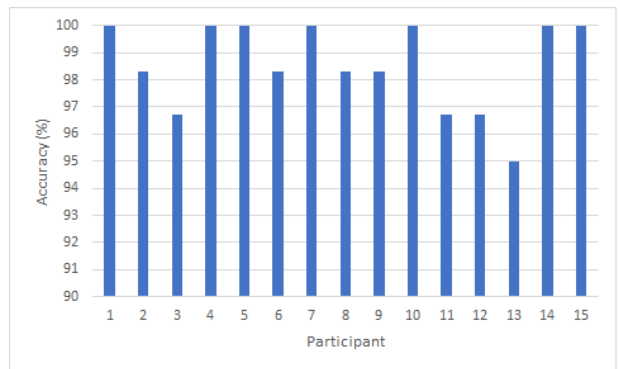
Figure 10. Accuracy per participant across all tasks: The prediction accuracy of participants movements across all